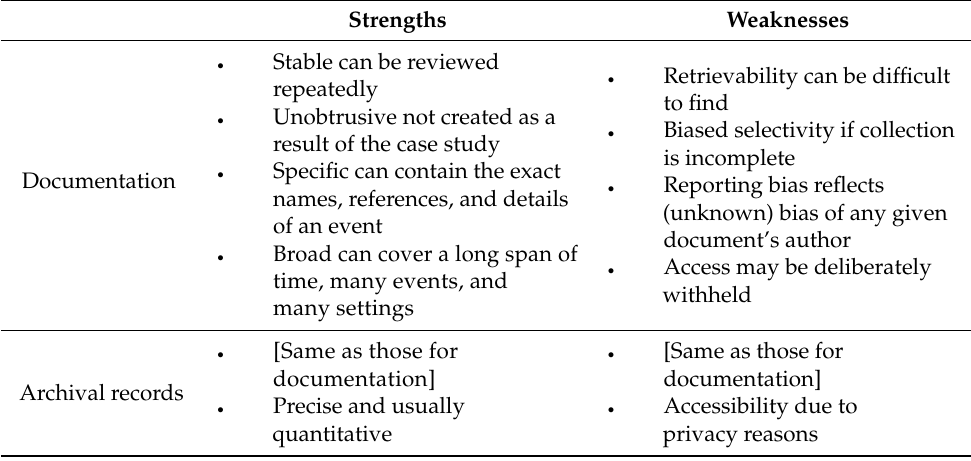
Table 2. Sources of evidence: strengths and